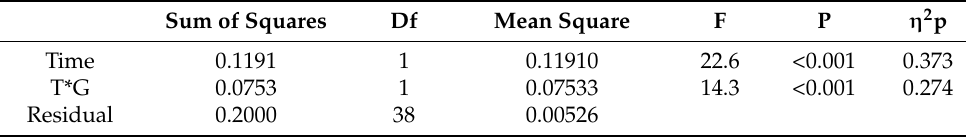
Table 5. Analysis of the Dm parameter within subjects